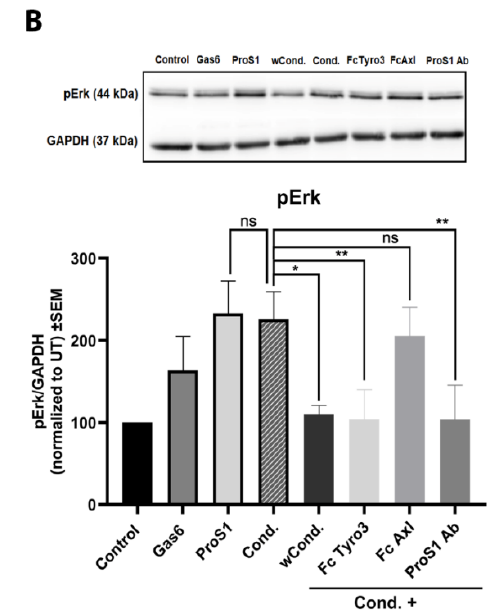
Figure 4. The effect of conditioned medium from 786-0 (producer) cancer cells on Tyro3 and Erk phosphorylation in SCC-25 (responder) cells. Cells were incubated for 9 min with recombinant proteins ProS1 (7.5 nM), Gas6 (5.7 nM), or conditioned media (cond.), without or with soluble TAM receptor ectodomains Fc-Axl or Fc-Tyro3 (3 µ g / mL), or anti-ProS1 antibody (5 µ g / mL). Conditioned medium was also applied from producer cells that had been pre-incubated with warfarin (wCond.). Cell lysates underwent Western blotting to detect phospho-Tyro3 ( A ) and phospho-Erk ( B ) proteins. Quantitative analysis by densitometric analysis of bands is shown graphically below each blot image. Data are mean ± SEM protein expression normalized against GAPDH as loading control protein; ANOVA with Tukey’s multiple comparison post-hoc analysis; *** p < 0.001, ** p < 0.01, * p < 0.05, and ns, not significant versus control (untreated, UT) or for comparisons indicated by lines (n = three separate experiments).